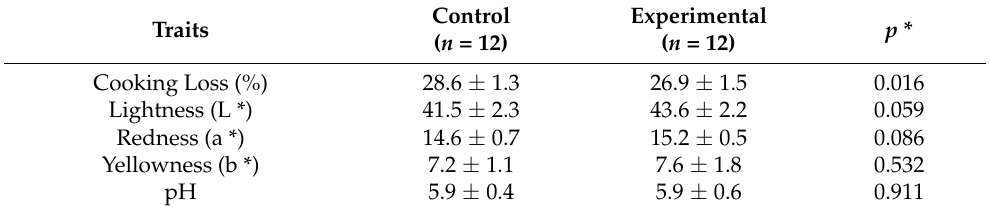
Table 4. Meat quality characteristics of control and SOD-rich melon supplement group of Tuj lambs.